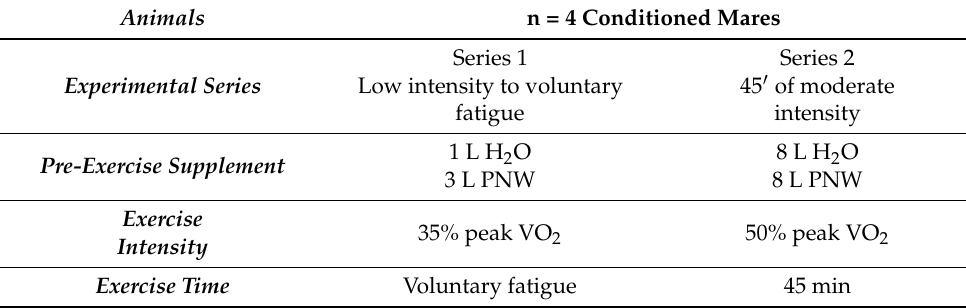
Table 1. Study design